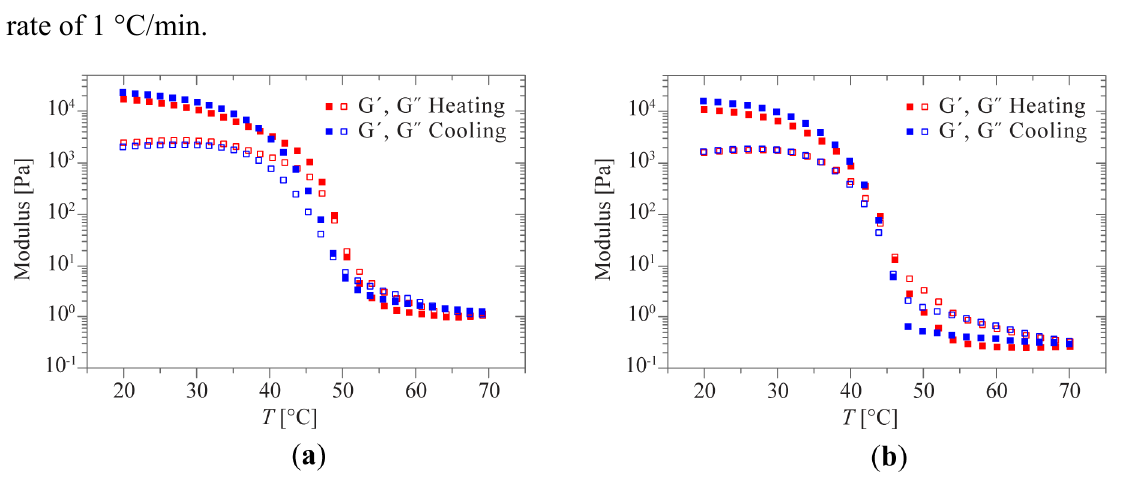
Figure 9. Small-angle X-ray scattering profiles of 1b at 10 wt % at 70 °C (black) and after 2 days (red), 8 h (green) and 0.5 h (blue) after cooling back to room